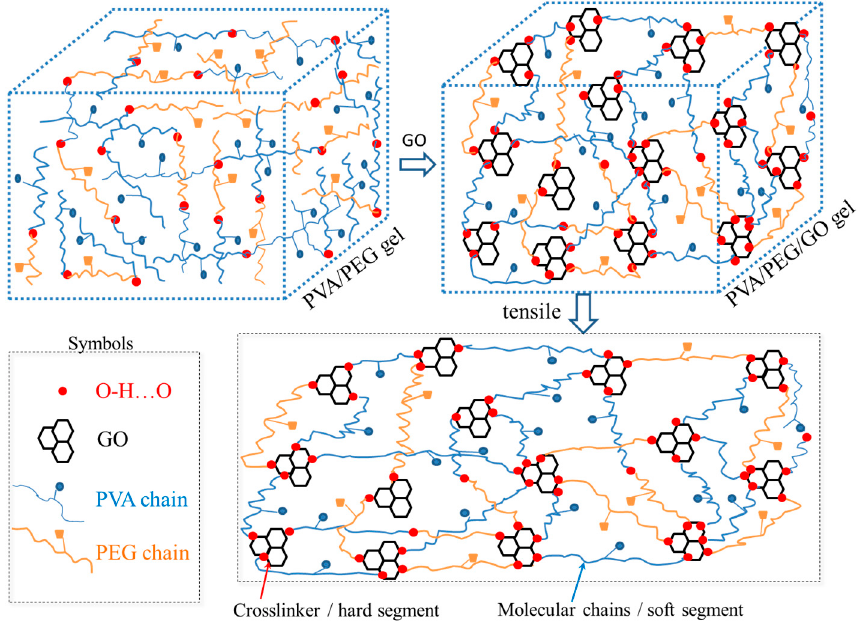
Figure 5. Schematic illustration of the molecule network of PVA/PEG/GO hydrogel from addition of GO nanoparticles into PVA/PEG sol before the freezing-thawing approach, and the deformation of the gel network under stretching, where the crosslinker on GOs means hard segments provide entropic elasticity and soft segments undertake the large tensile strain.